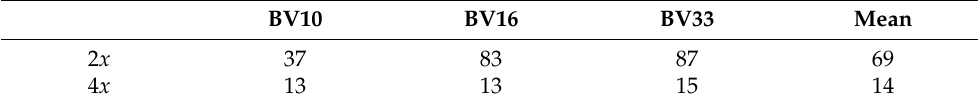
Table 8. Outcrossing rates (%) for clones and ploidy